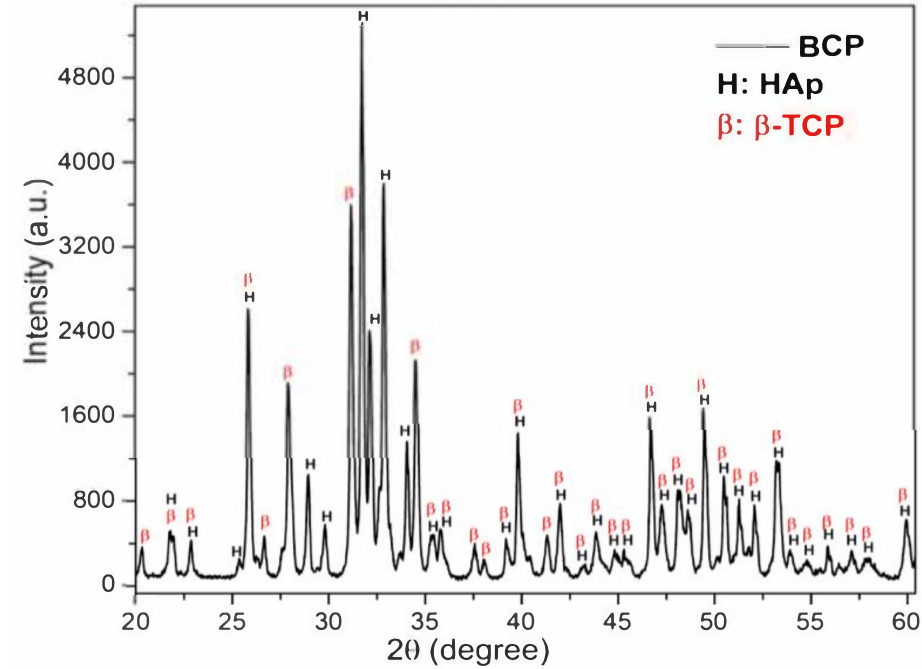
Figure 2. DRX pattern of BCP powder obtained by calcining fish bones at 900 ◦ C for 8 h and milling in a high-energy mill for 4 h at 600 r.p.m. The peaks related to the phases, HAp and β -TCP, are indicated by the letters (H) and (B), respectively. BCP = biphasic calcium phosphate; HAp = Hydroxyapatite; β -TCP = β -tricalcium